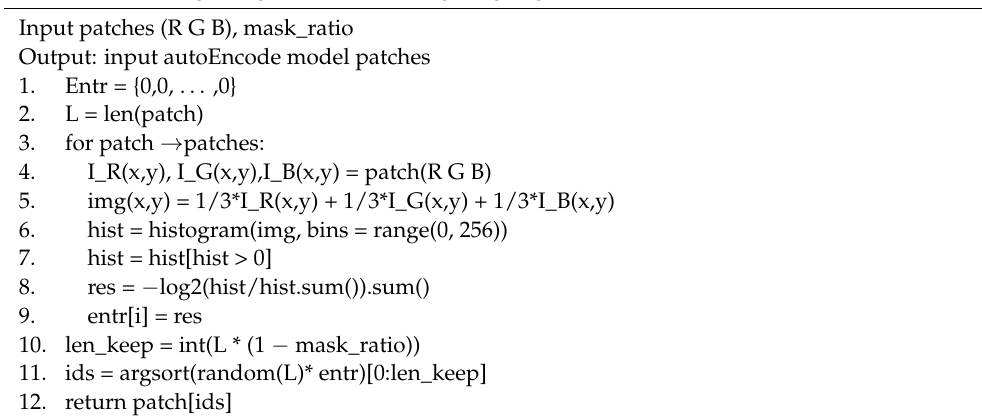
Algorithm 1: Image Fragmentation IE Weighting